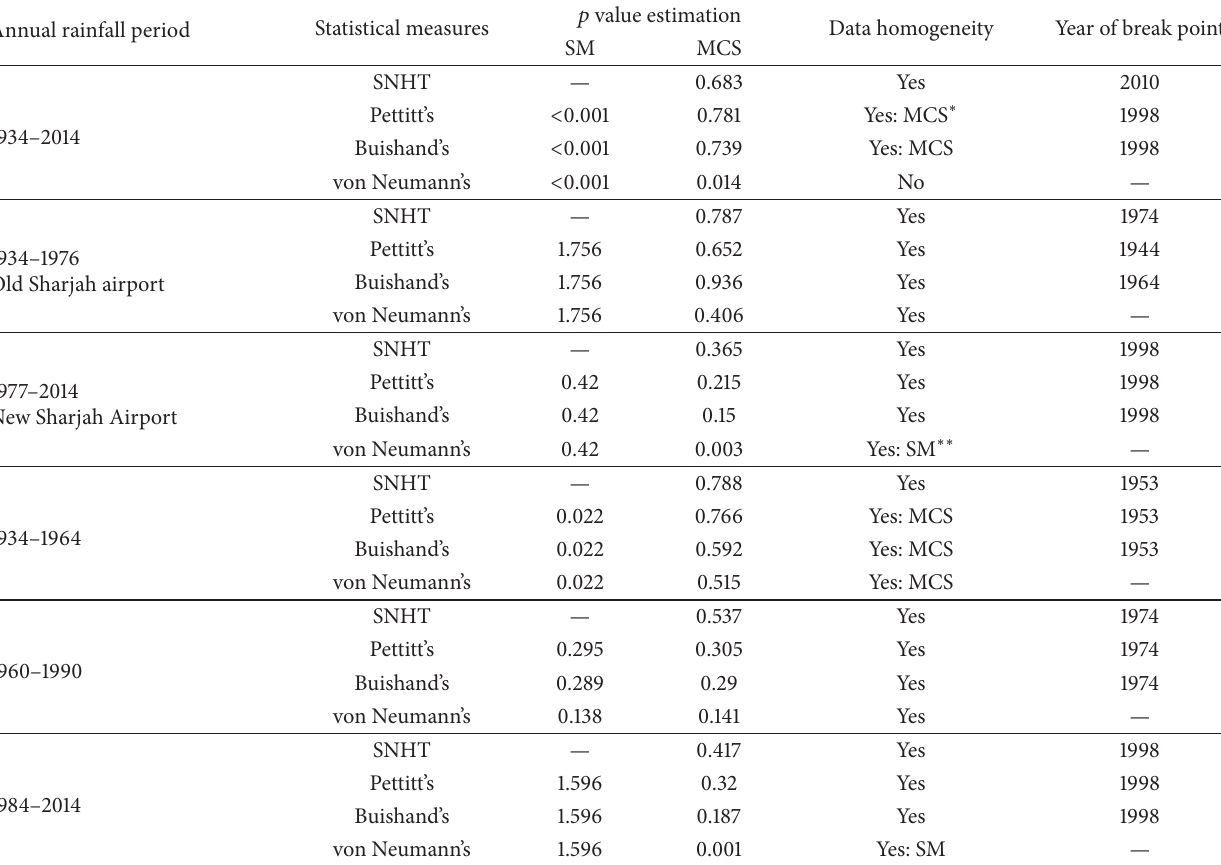
Table 1: Homogeneity tests (two-tailed, 𝛼 = 5%) of Sharjah annual rainfall applied to different aggregated